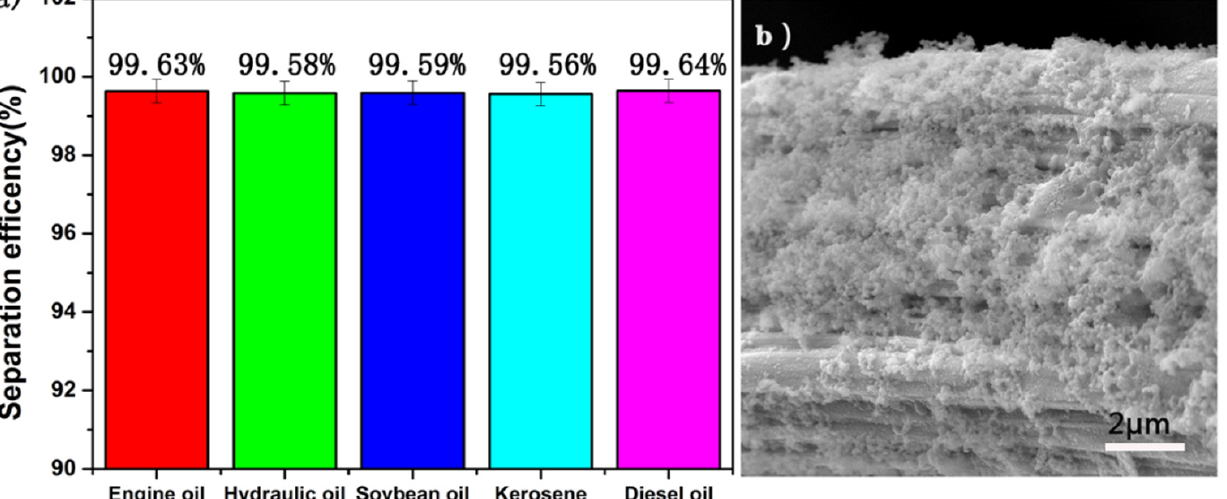
Figure 7. ( a ) The separation efficiency of SiO 2 -Na 2 SiO 3 -coated SSF after being immersed in hot water for 2 weeks and ( b ) corresponding SEM image.